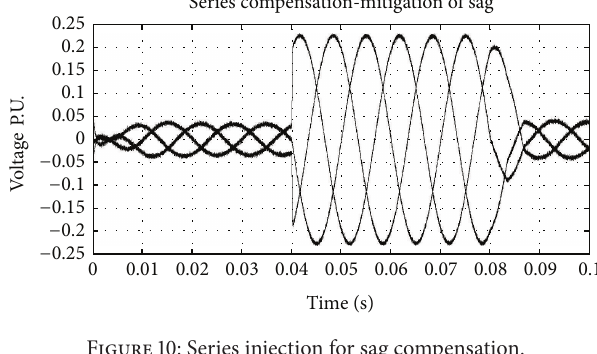
Figure 10: Series injection for sag compensation.